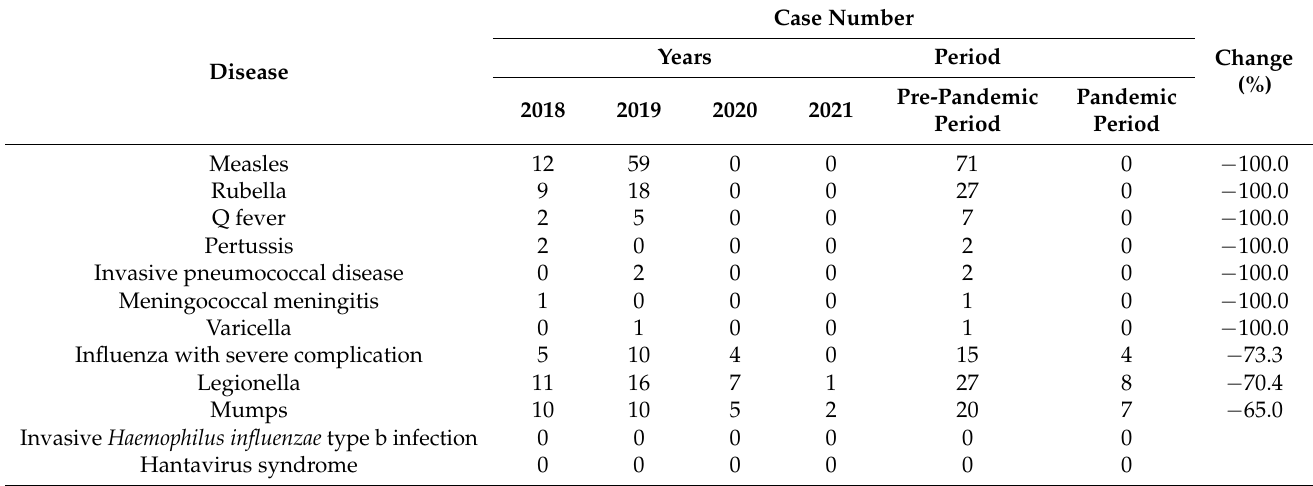
Table 3. The case number of imported airborne/droplet-transmitted notifiable infectious diseases.